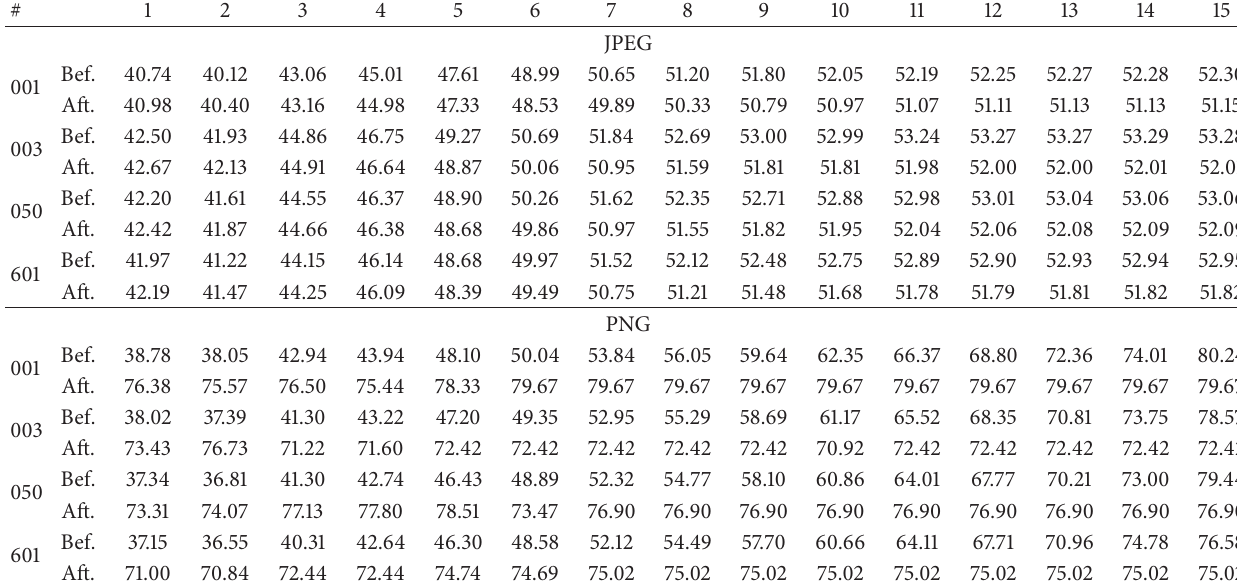
Table 8: PSNR result before and after pixel